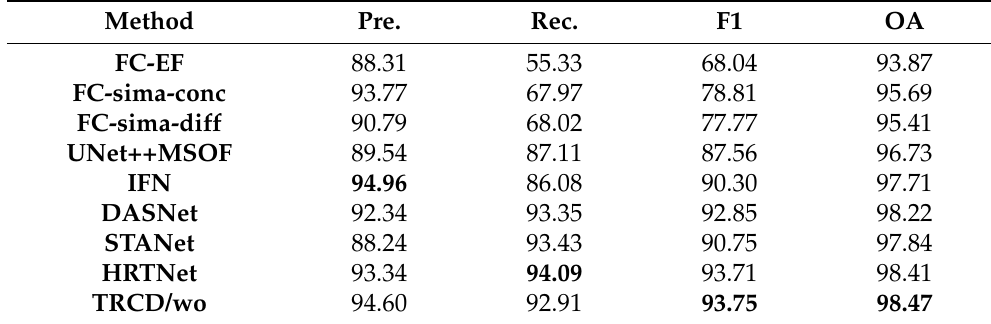
Table 1. Evaluation results of TRCD and other advanced algorithms on CDD with 3000 pairs of images. Method